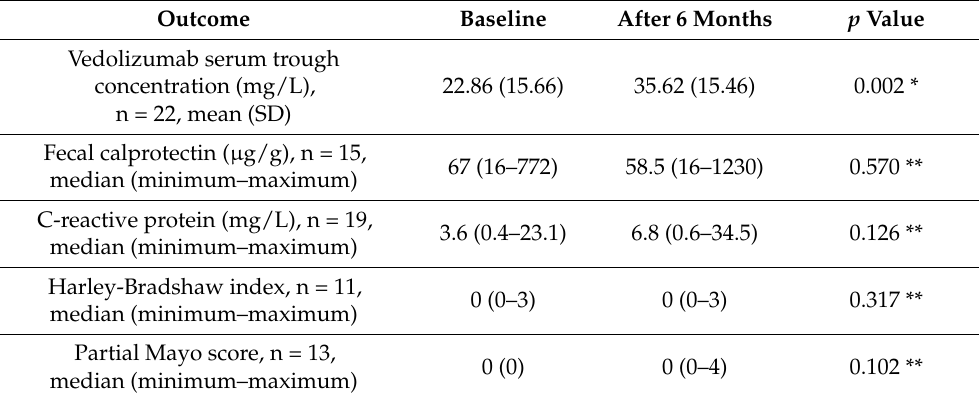
Table 2. Change in vedolizumab trough concentration, fecal calprotectin level, C-reactive protein level, Harvey–Bradshaw index, and Partial Mayo score before and after transition from intravenous vedolizumab to subcutaneous